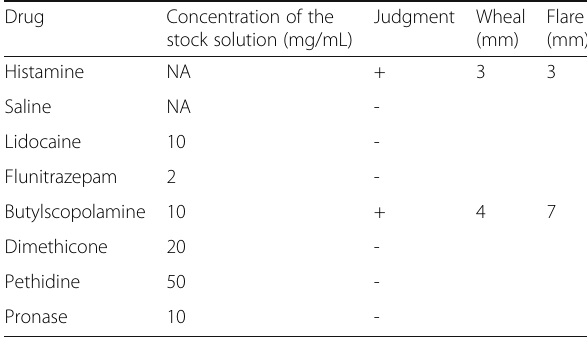
Table 2 Results of skin prick